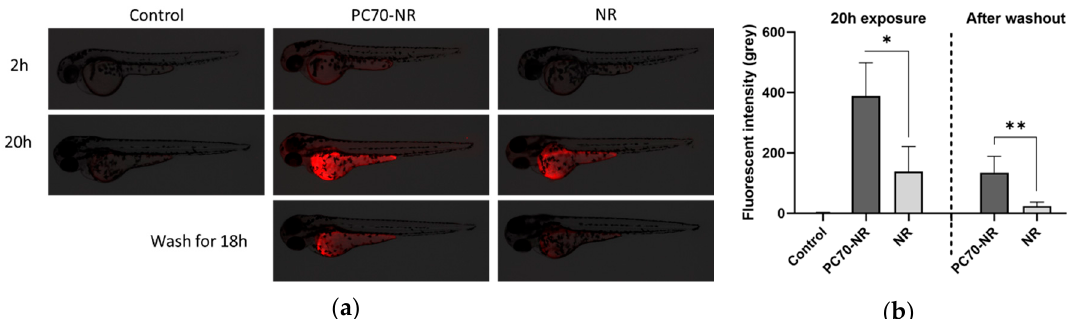
Figure 2. Visualization of the PC70 drug delivery system using PC70-Nile Red (PC70-NR) treatment in zebrafish larvae. ( A ) Representative images of PC70-NR- or NR-treated zebrafish. Seventy-two hpf larvae were exposed to 1% PC70-NR (containing 200 µg/mL PC70 with 1 ng/mL NR) or 1 ng/mL NR for 2 and 20 h, respectively. Following this, the fish were washed in breeding water for 18 h. Red colouration indicated NR fluorescence. ( B ) Quantification of NR fluorescence in zebrafish treated with PC70-NR or NR. * p < 0.05, ** p < 0.01. Each experimental group contained 12 fish; error bars indicate SD.